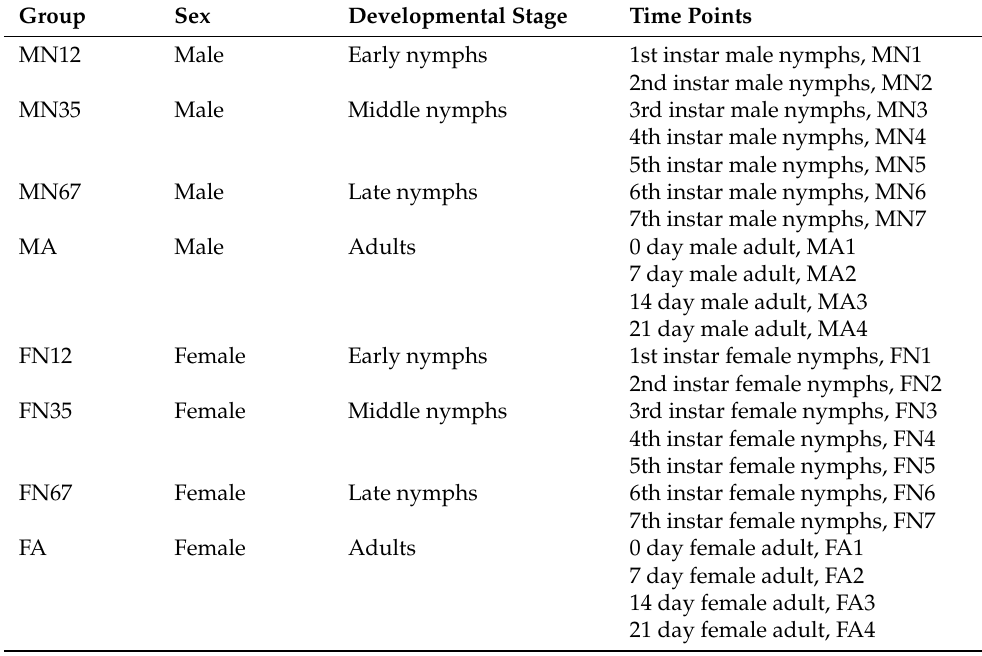
Table 1. The sample labels and group information of this